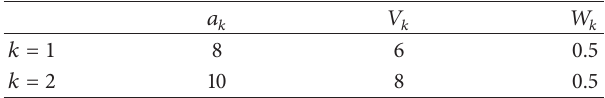
Table 2: Parameter settings of variables for the model.